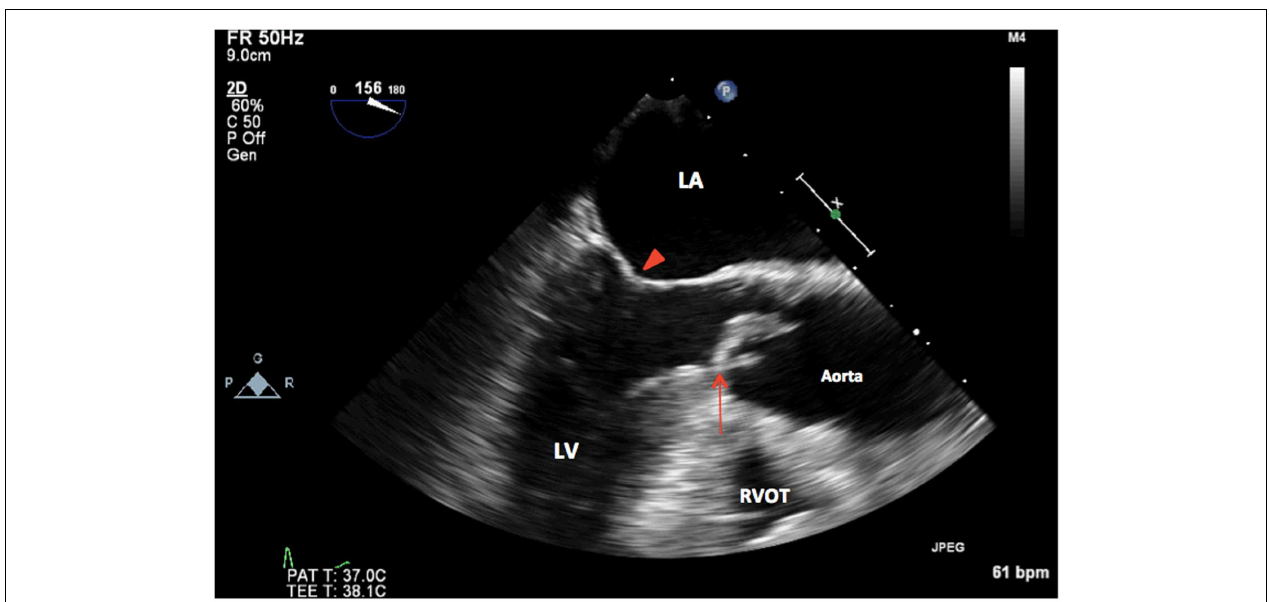
FIGURE 3 | 2DTEE midesophageal long-axis view showing thickened, calcified unicuspid aortic valve in systole (arrow). LA, left atrium; LV, left ventricle, mitral valve (arrowhead); RVOT, right ventricular outflow tract.